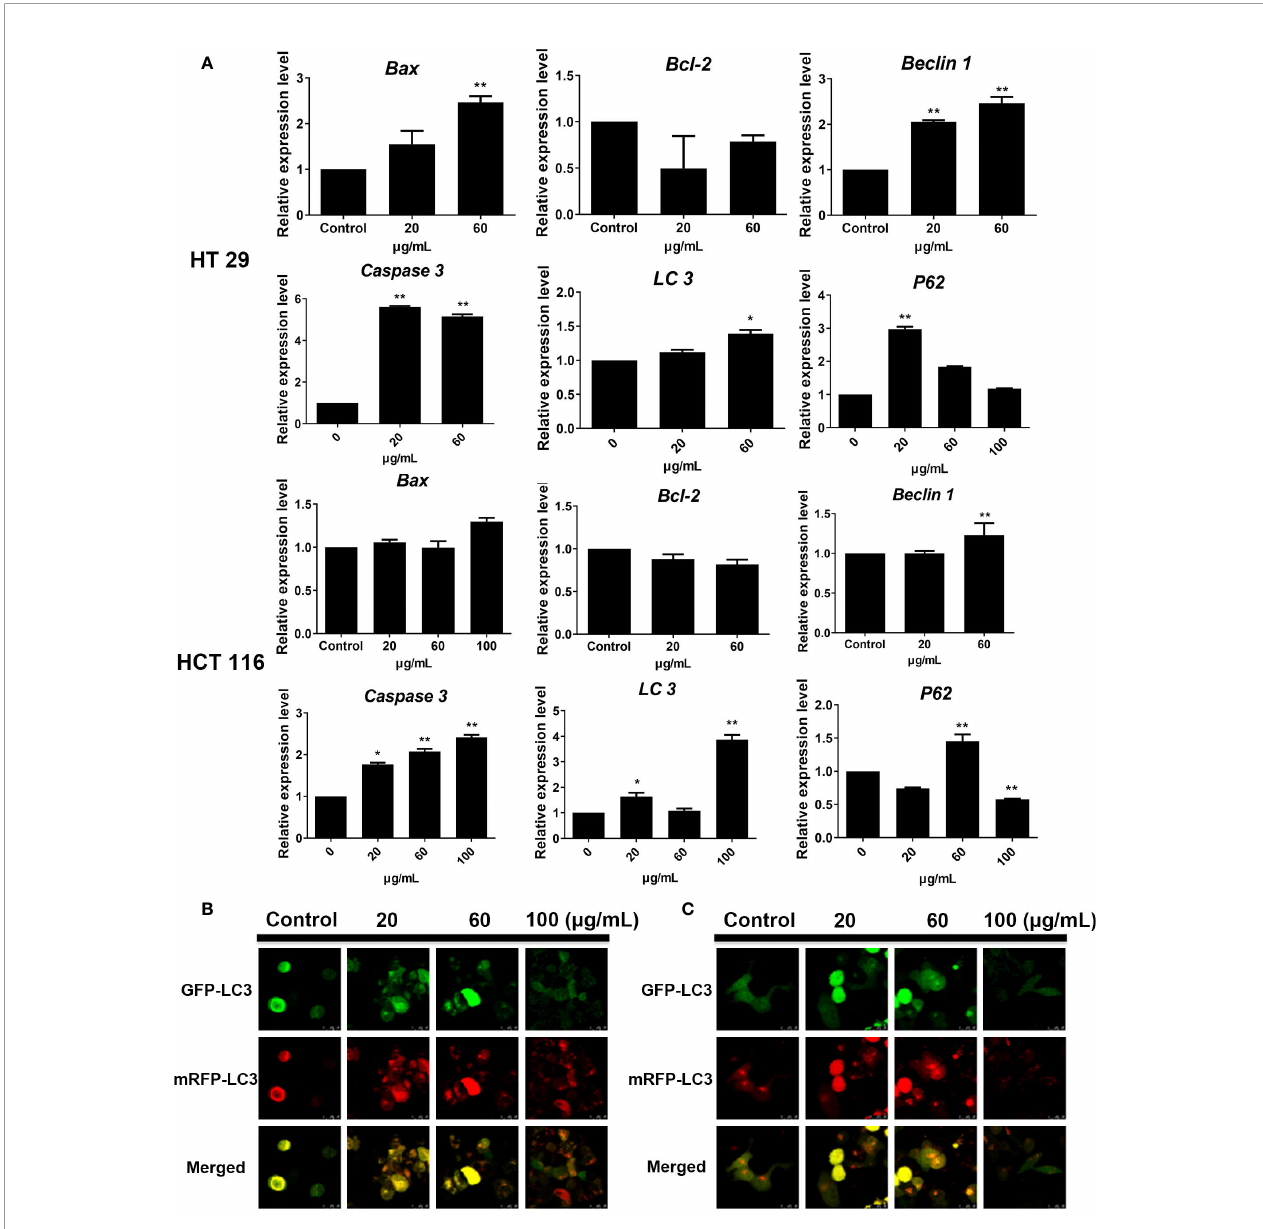
FIGURE 6 | Effect of SDEA on the expression levels of apoptosis-related genes in cells and the GFP and mRFP signals of tandem fl uorescent LC3. (A) effect of SDEA on the mRNA of apoptosis-related genes (Caspase-3 , Bax , and Bcl-2 ) and autophagy-related genes ( LC3 , P62 , and Beclin-1 ) in HT29 and HCT116 cells, respectively, * p < 0.05; ** p < 0.01, vs. control group. (B, C) GFP and mRFP signals of tandem fl uorescent LC3 (tfLC3, mRFP-GFP-LC3), respectively, showing autophagic fl uxes in HT29 and HCT116 cells transfected with adenovirus expressing tfLC3 for 48 h and treated with different SDEA